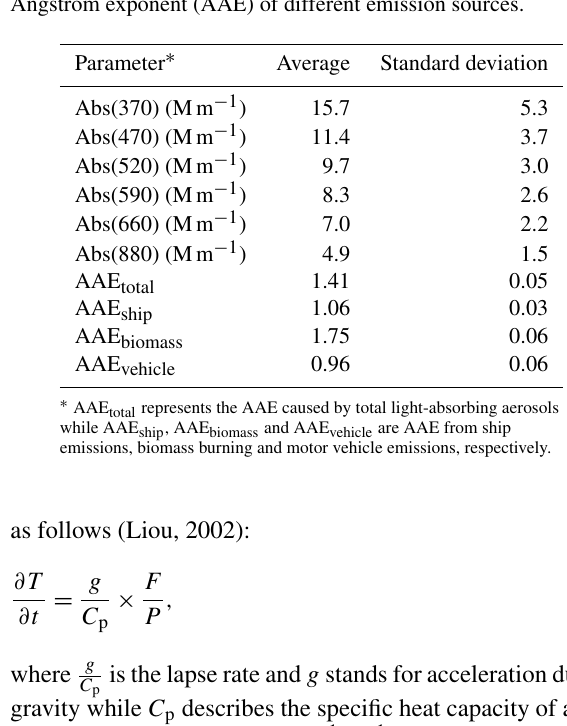
Table 1. Summary of light absorption at different wavelengths (Abs( λ ), λ = 370, 470, 520, 590, 660 and 880nm) and absorption Ångström exponent (AAE) of different emission